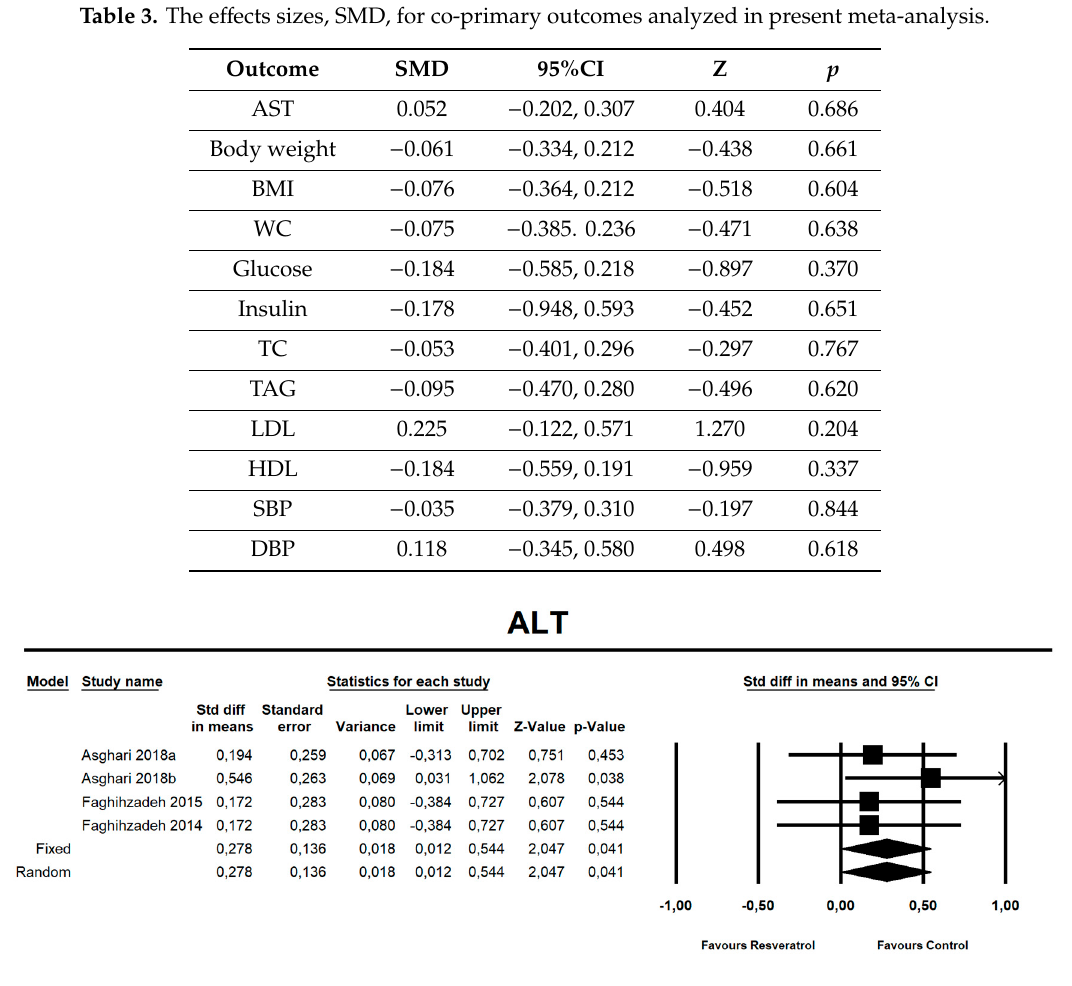
Table 3. The effects sizes, SMD, for co-primary outcomes analyzed in present meta-analysis.